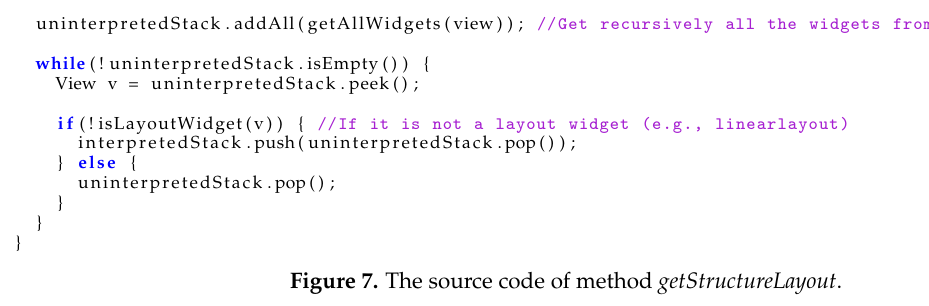
Figure 7. The source code of method getStructureLayout .